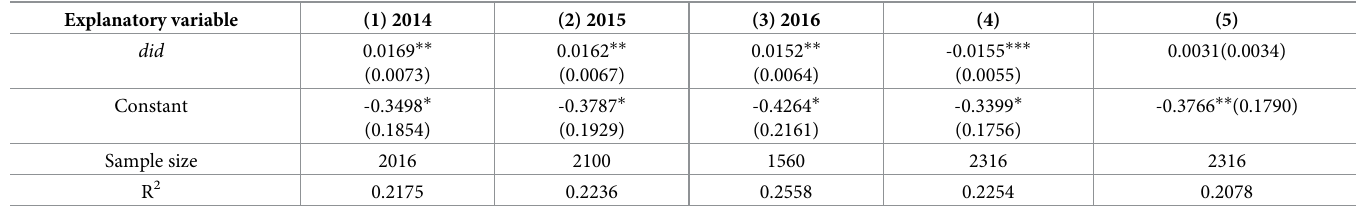
Table 5. Robustness